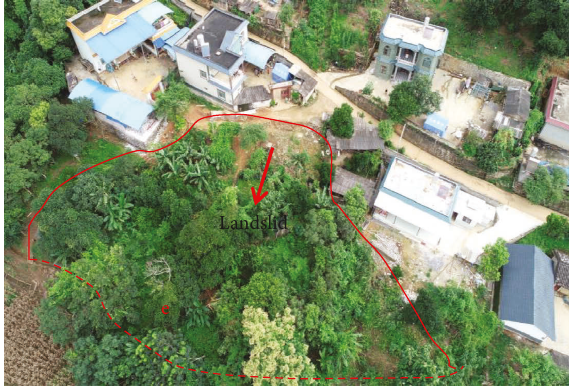
Figure 15: Aerial view of the Dawanjiang